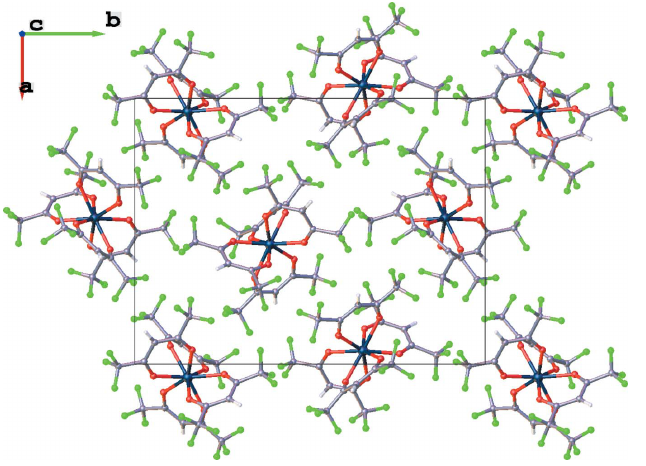
Figure 3 A single layer of Hf(hfac) 4 molecules as viewed along the c axis.